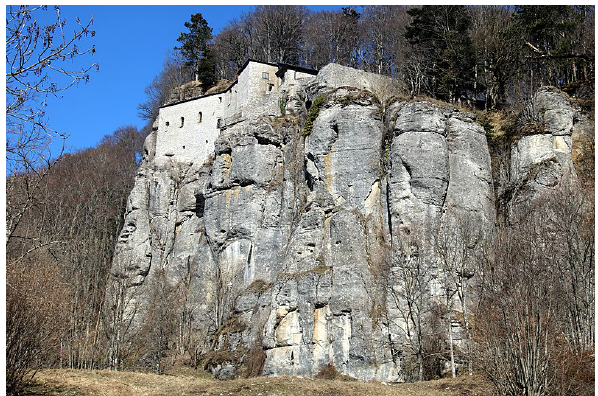
Figure 17. The monastery at La Verna, located on Mt. Penna, com- posed of Miocene calcarenite. Source: public domain – Wiki Com-